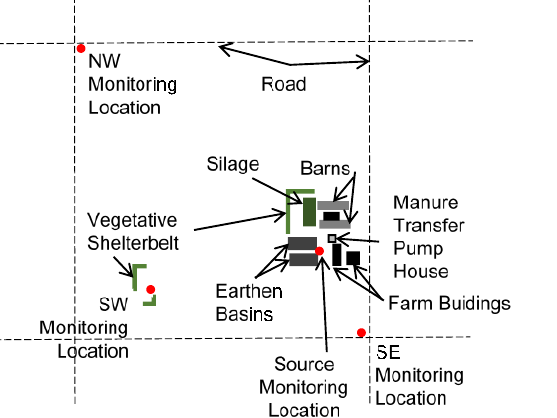
Figure 1. Layout and monitoring locations around a dairy facility for the dairy case study (not to scale).